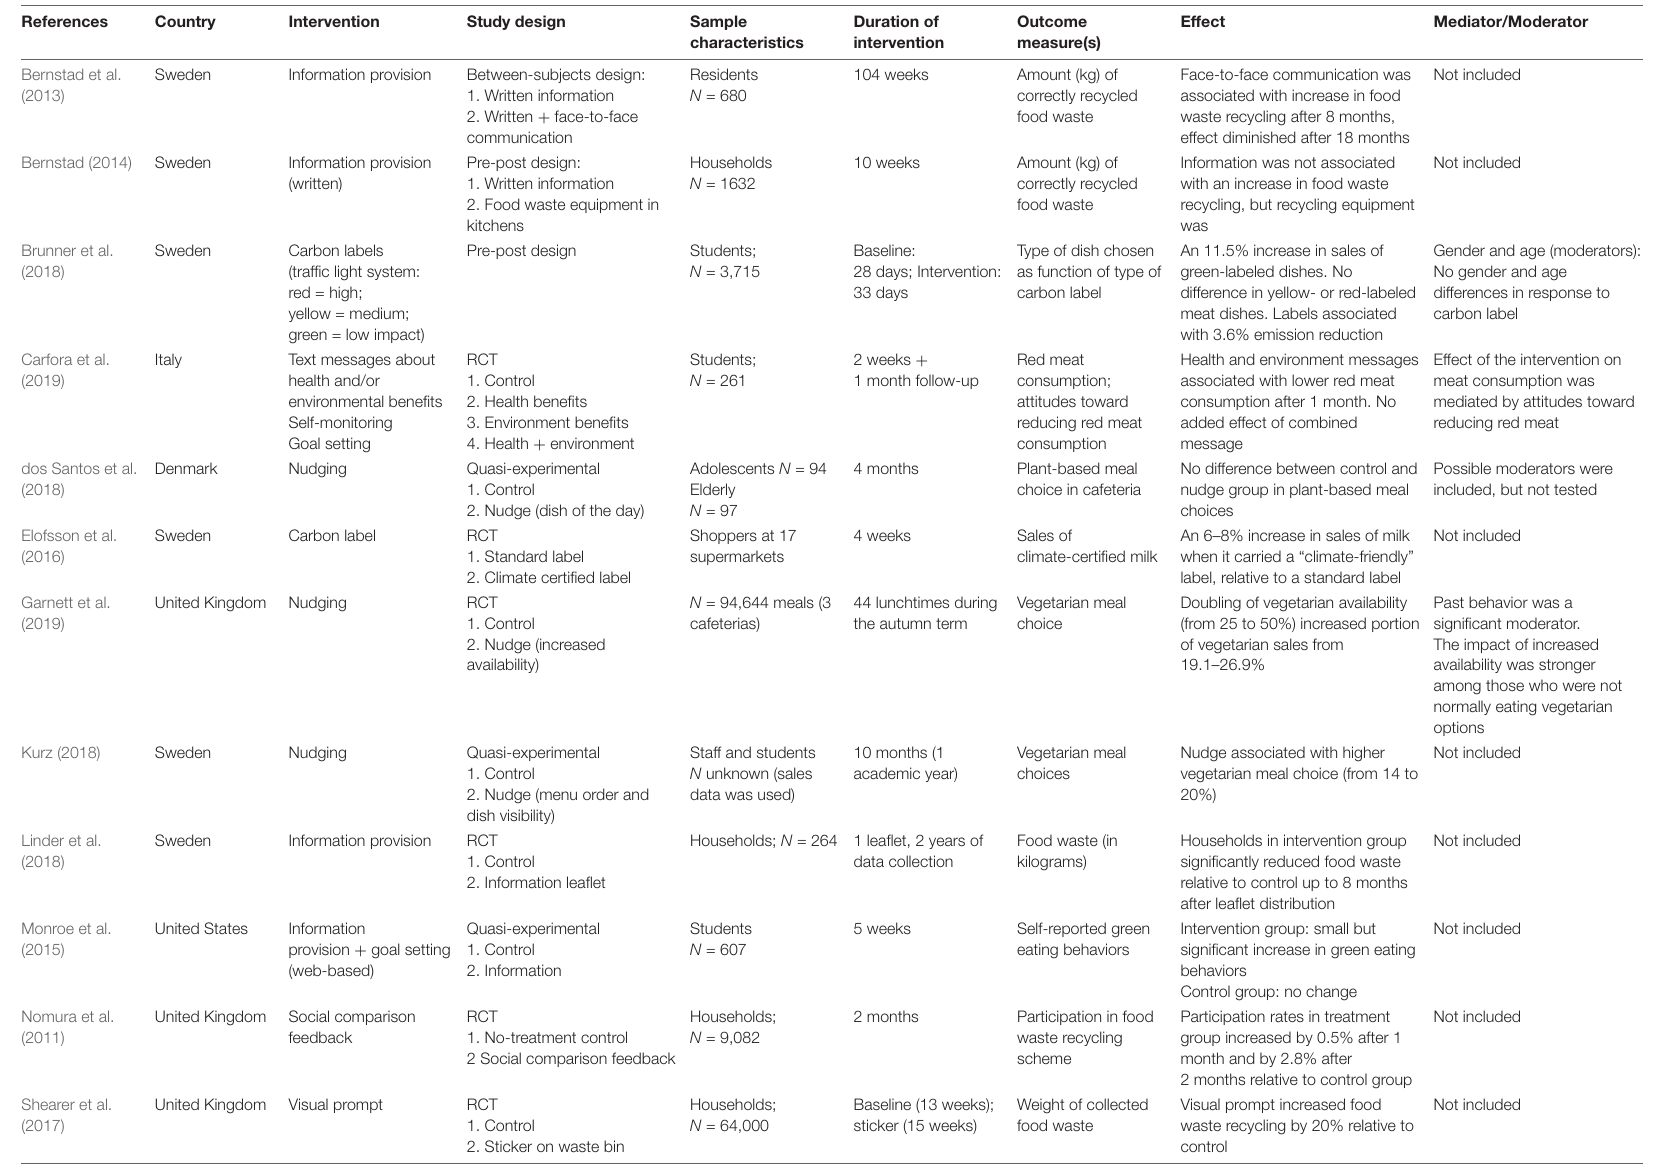
TABLE 1 | Summary table of key characteristics of the intervention studies included in this